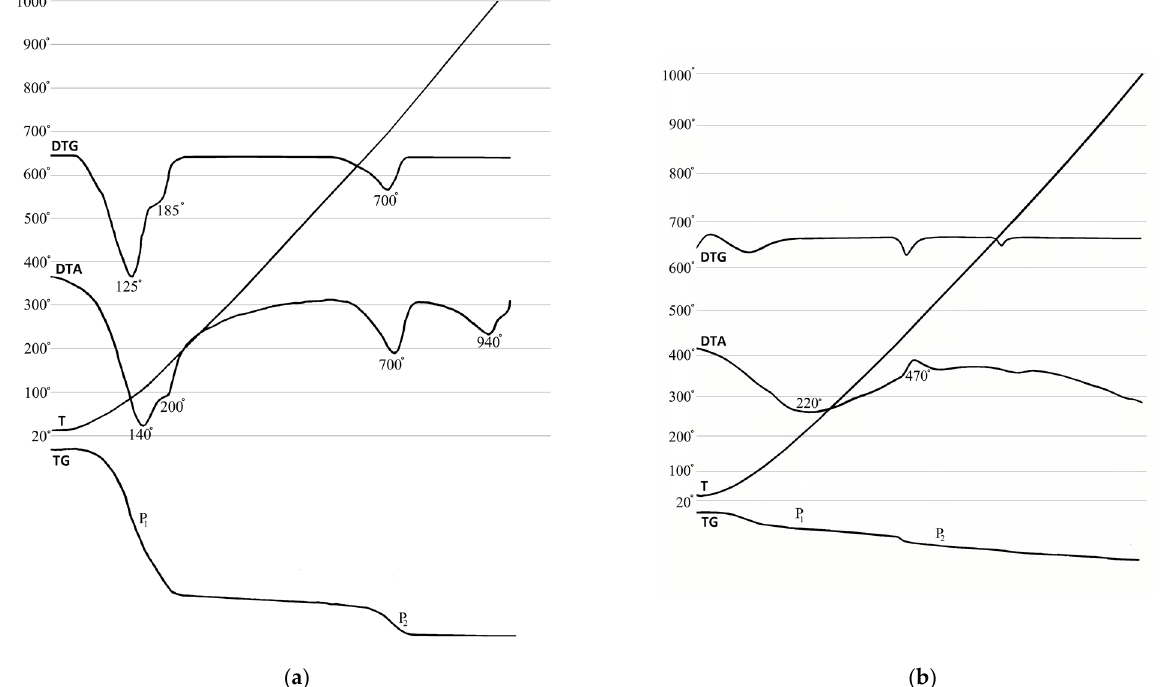
Figure 10. Thermal analysis of the montmorillonite and cristobalite: DTG—derivative thermogravimetry; DTA—differential thermal analysis; TG—thermogravimetry; T—temperature 20–1000 °C, P 1 and P 2 —weight losses. ( a ) white nano-/microstructured Ora ș u Nou-montmorillonite; ( b ) cristobalite.